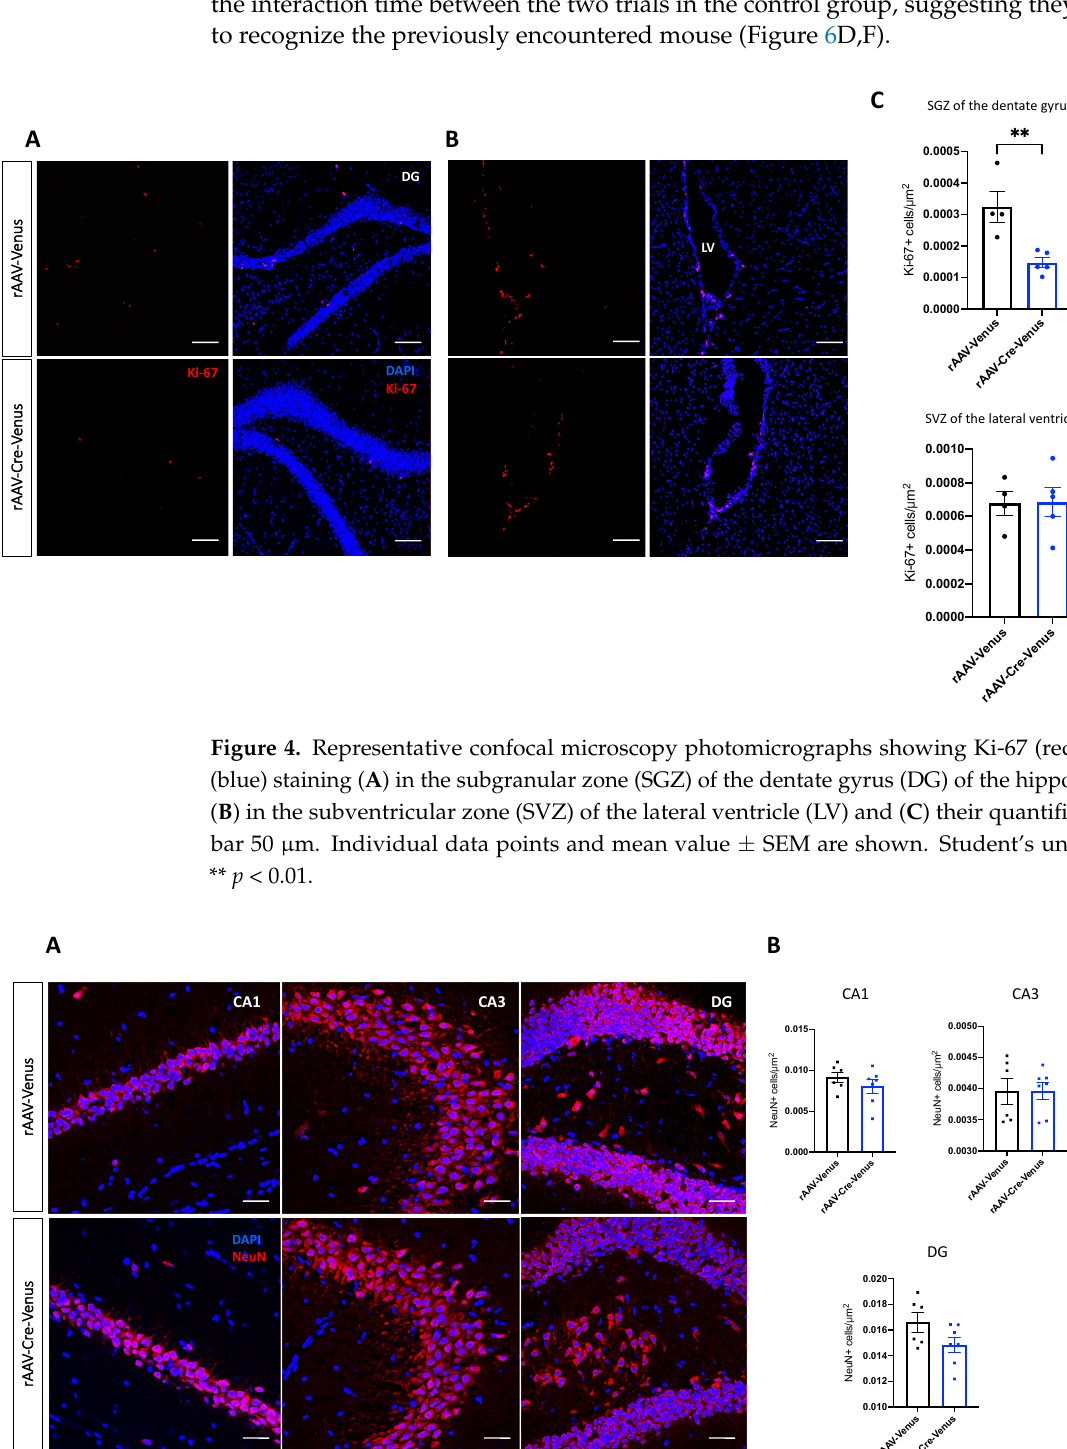
Figure 5. ( A ) Confocal microscopy pictures of NeuN (red) and DAPI (blue) immunofluorescence and ( B ) their quantification in the three regions of the hippocampus. Scale bar 25 µ m. Individual data points and mean value ± SEM are shown. Student’s unpaired t